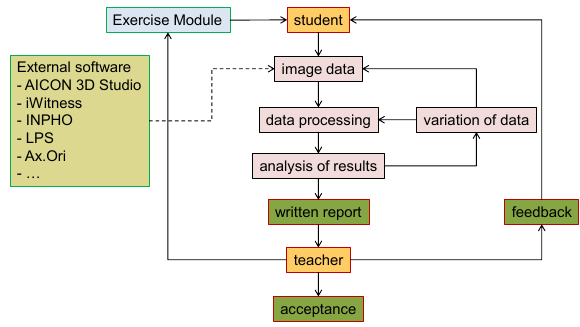
Figure 17: Work flow for exercises in PhoX As a result of this new concept, the number of students that pass the exams successfully at their first attempt has been increased significantly. As a positive side effect, students get a better relationship to